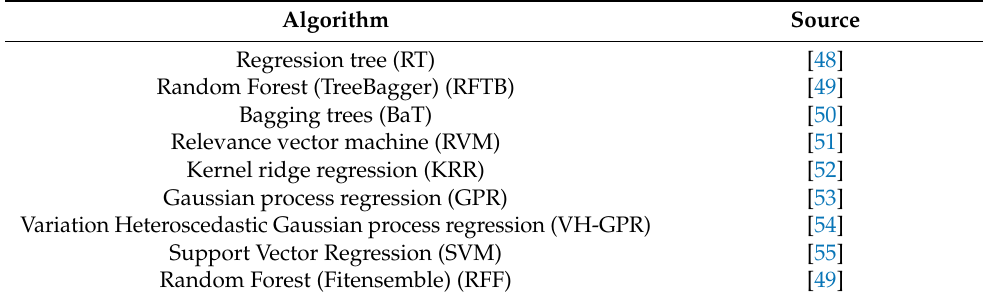
Table 4. Machine learning regression algorithms tested for LAI modelling.